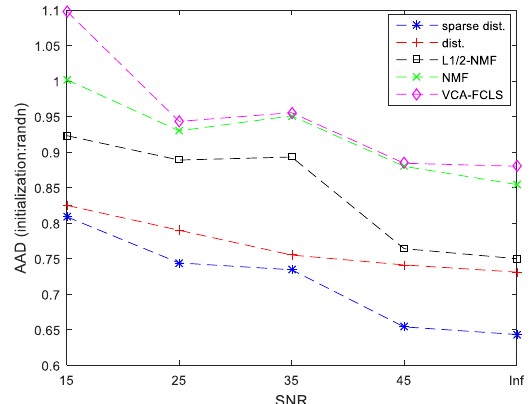
Figure 3. The AAD performance metric of 5 methods versus SNR, using random initialization and applied on synthetic data. AAD of the proposed algorithm is star-dashed line.